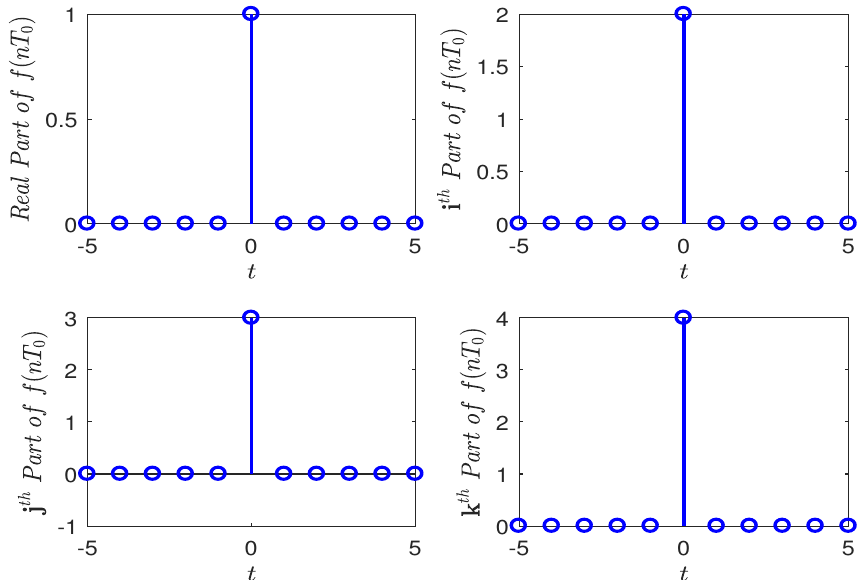
Figure 3. The sampled parts of the quaternion-valued signal given by f ( nT 0 ) .